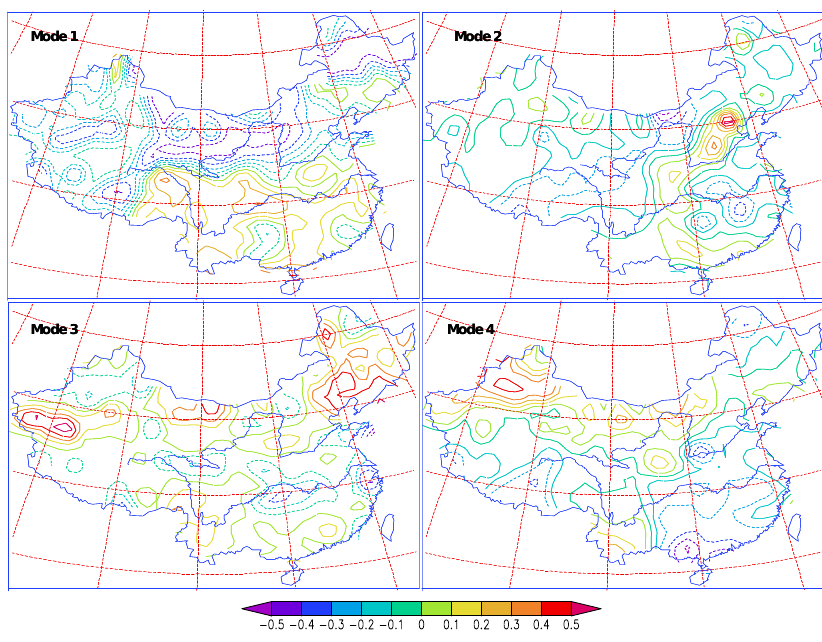
Fig. 10. Visibility mode (principal component) coefficient distributions that resolved by REOF method on the basis of 14:00 surface visibility data from 681 meteorological stations in China during 1957–2005. Contours denote the correlation among visibility variations in different